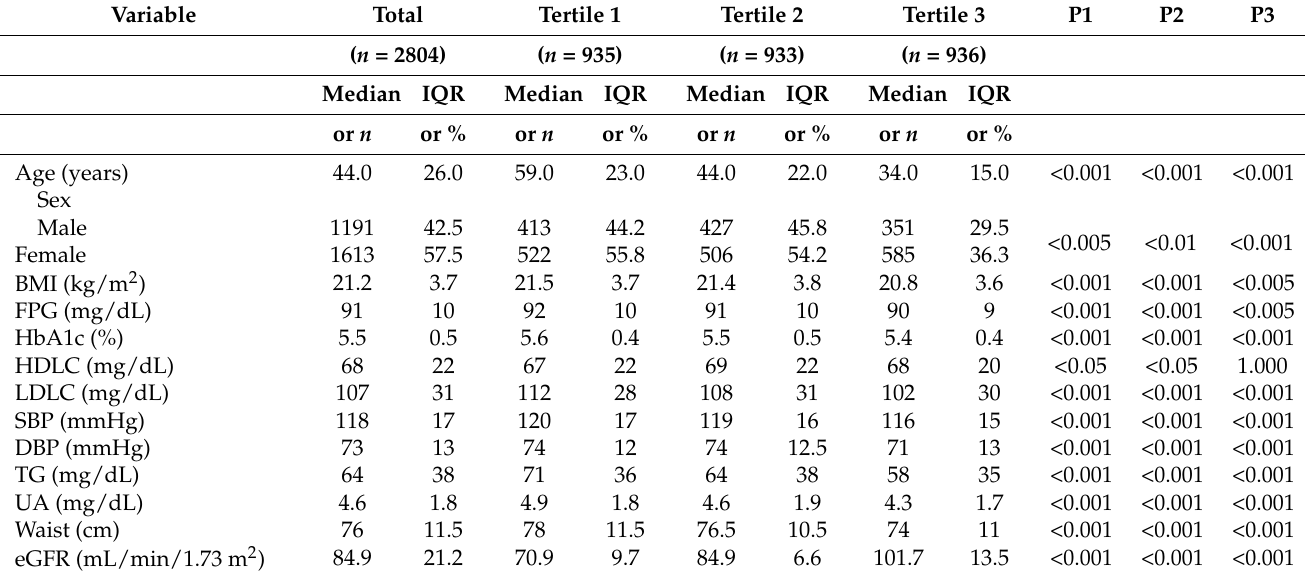
Table 1. Demographic and clinical characteristics of study subjects. Values are expressed as median and interquartile range (IQR) for continuous variables and as a number and a percent (total or within tertiles) for the categorical variable.